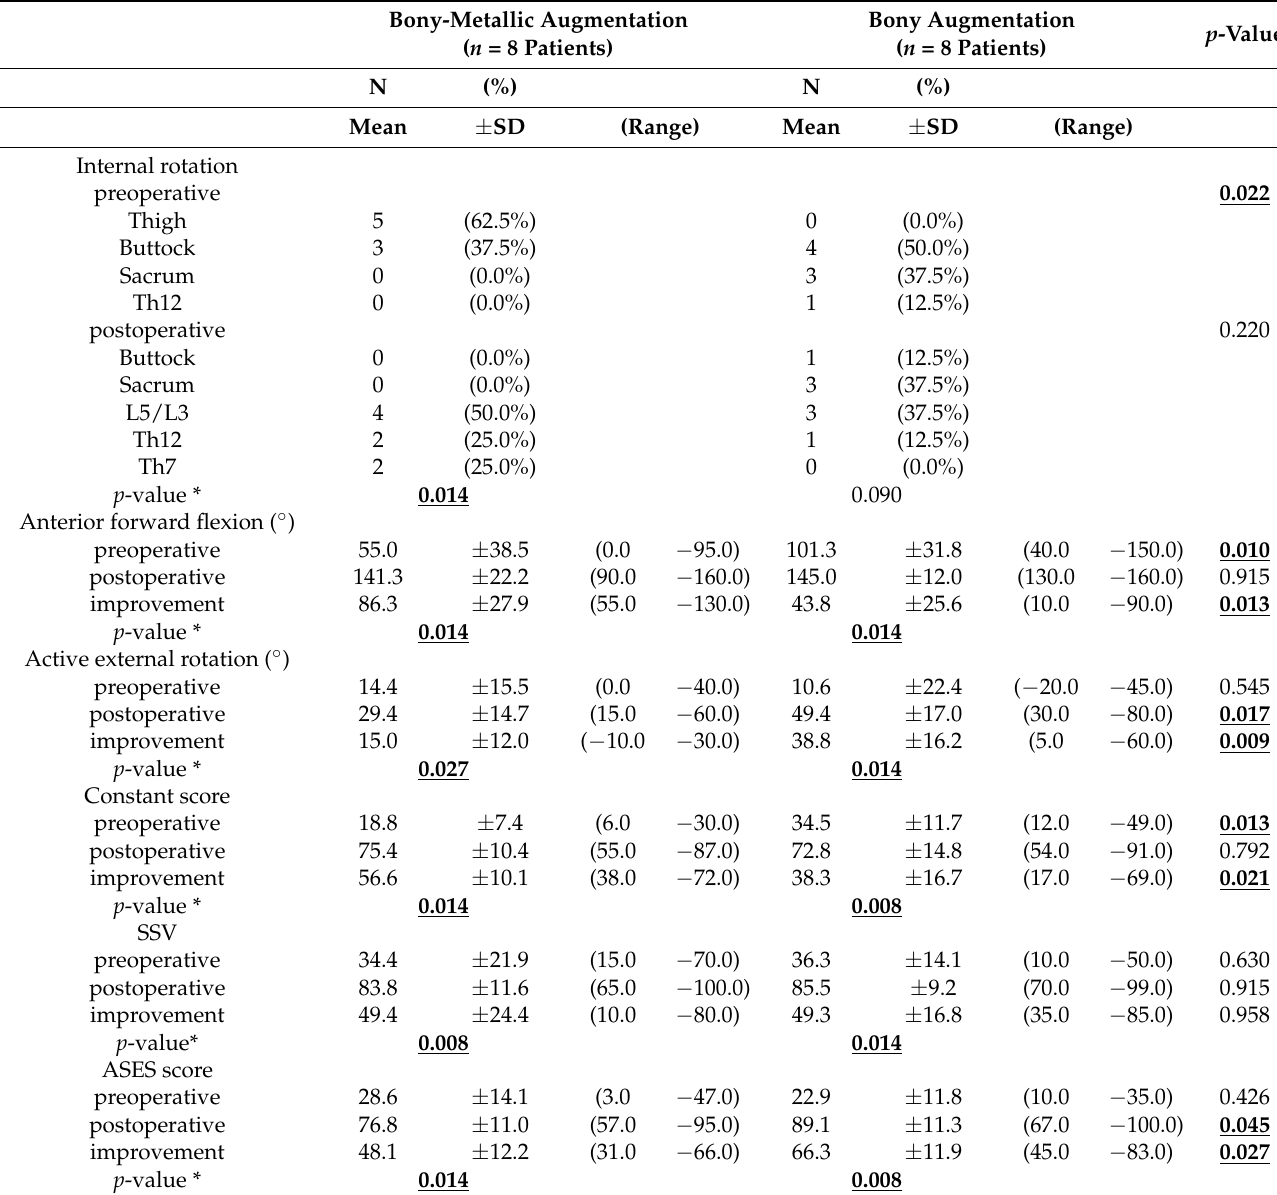
Table 3. Pre- and postoperative data between the Bony-metallic augmentation (BMA) and Bony augmentation (BA) groups. Bony-Metallic Augmentation Bony ( n = 8 Patients)